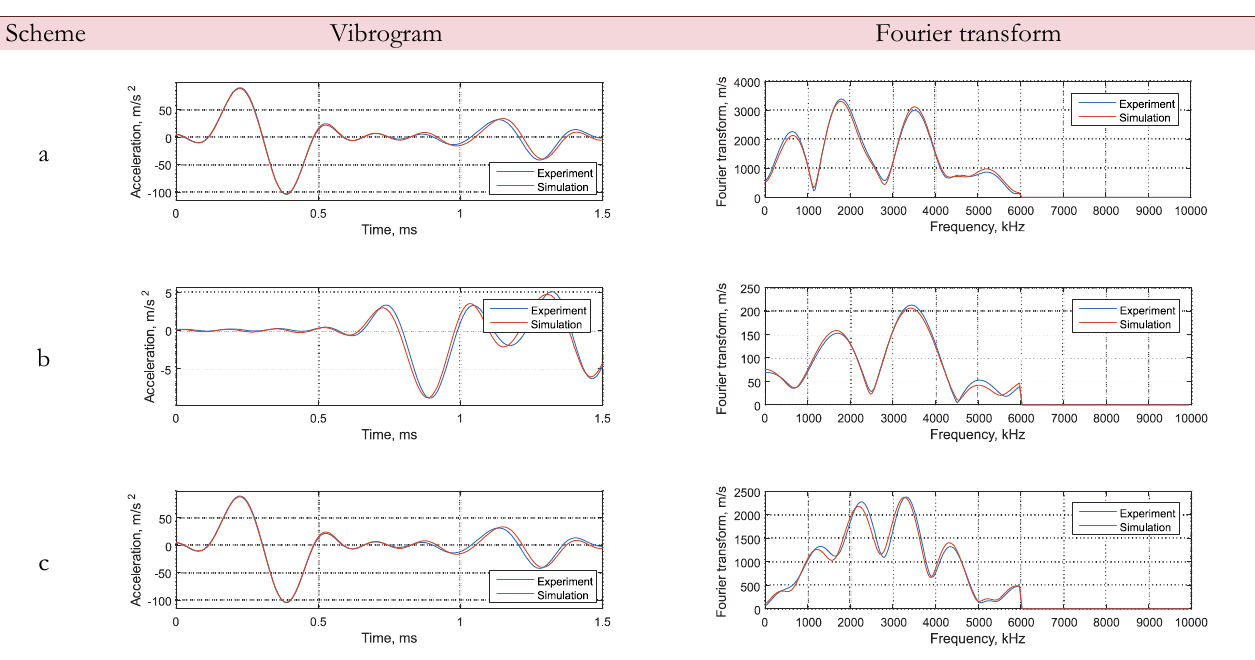
Figure 5: Vibrograms and corresponding Foutier transforms for three loading